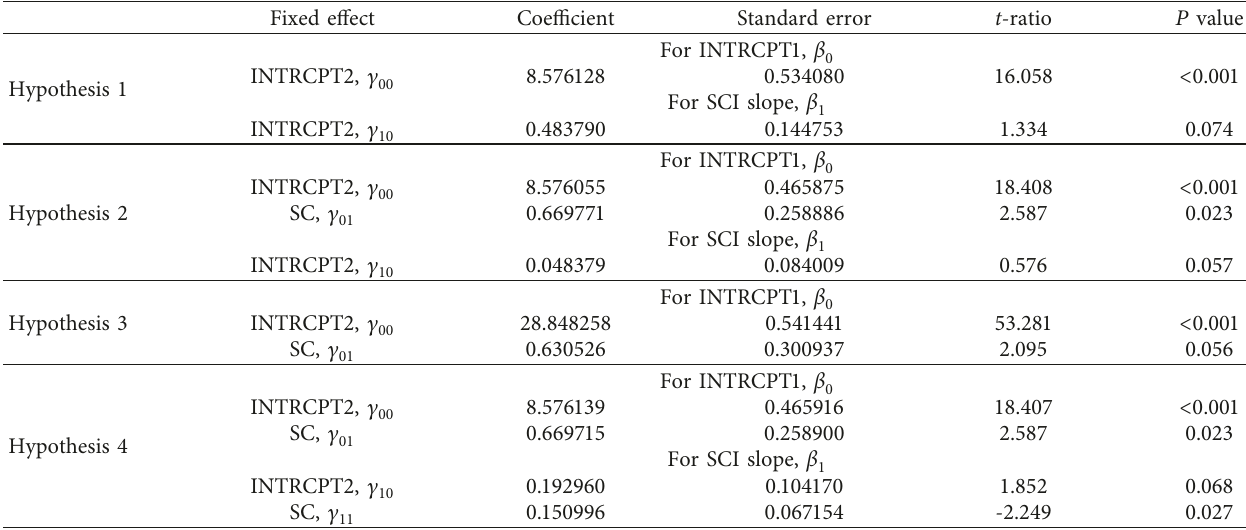
Table 3: HLM test on